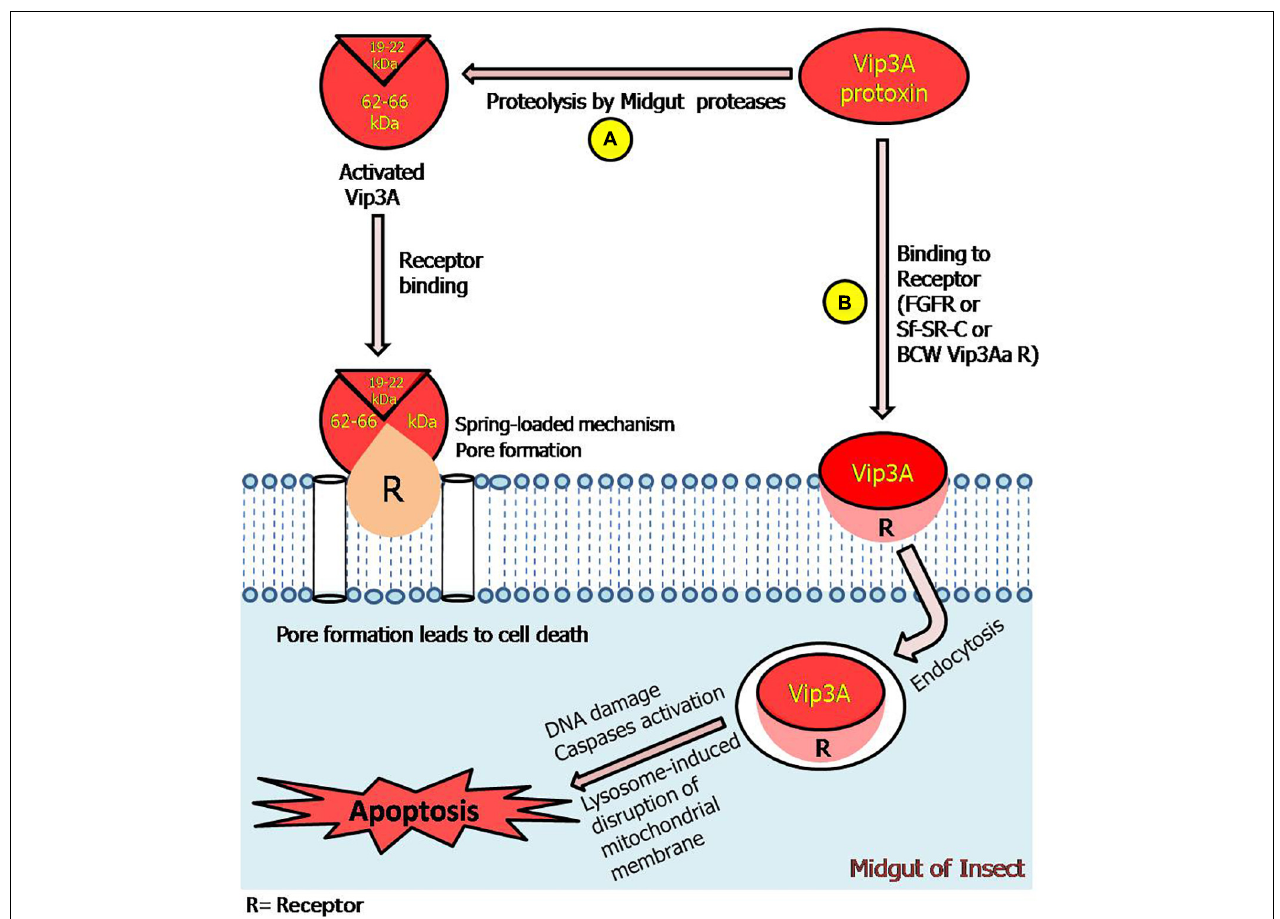
FIGURE 5 | Model representing Vip3A proteins-insecticidal mechanism through pore formation and apoptosis. (A) The ∼ 62–66 kDa fragments along with ∼ 19–22 kDa fragment can bind with receptors leading to pore formation and cell death. (B) This represents that Vip3A-protoxin can bind to all three specific receptors in the target insect. Thereafter, enter the cell through receptor-mediated endocytosis and induced activation of caspases, DNA damage, and lysosome-induced disruption of the mitochondrial membrane which leads to apoptosis process in Sf9 cells and ultimately insect mortality. However, the responsible signaling pathway is still